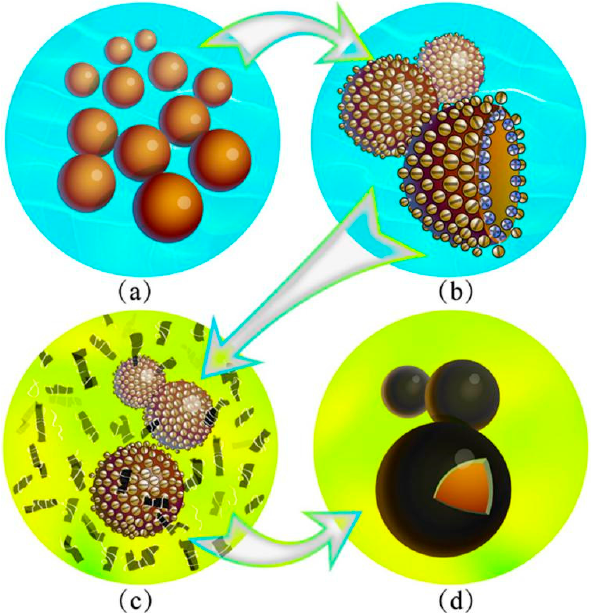
Figure 2. Illustration of microcapsules fabrication process by a self-assembly method, ( a ) core material emulsified by SMA molecules, ( b ) the emulsified droplets with negative charge on surface, ( c ) HMMM prepolymer and graphene adsorbed on core droplets by charge, HMMM prepolymer added dropwise and attached to the surface of the droplets, droplets with positive charge, and ( d ) three-dimensional anatomical structure of microcapsules with graphene/HMMM shells.